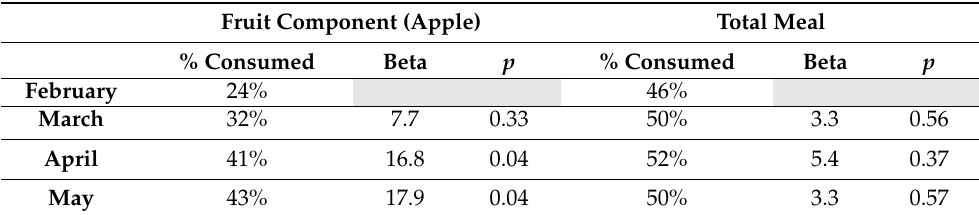
Table 3. Linear regressions for percent consumption of fruit and total meal by month for 3rd–5th graders who selected apples, n = 115. Fruit Component (Apple) Total Meal % Consumed Beta p %